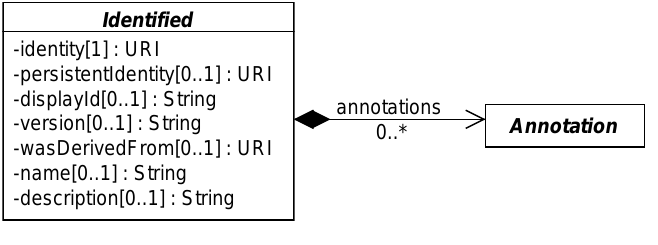
Figure 4: Diagram of the Identified abstract class and its associated